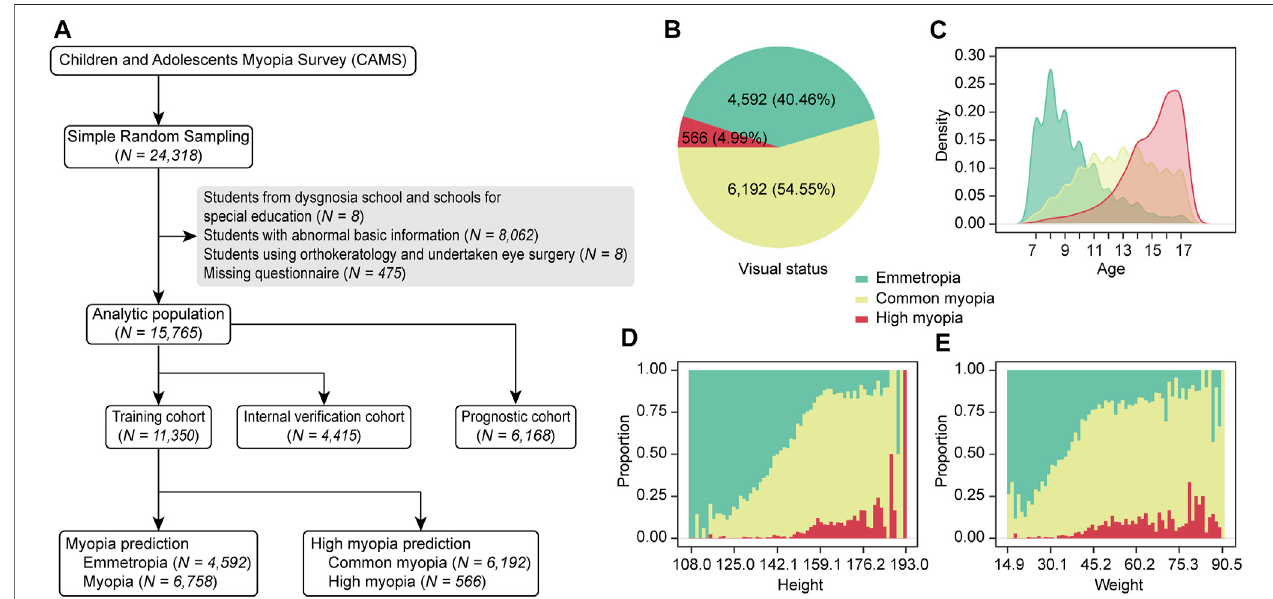
FIGURE 1 | Flowchart and distribution of the study cohort. (A) Numbers of participants. (B) Distribution of visual states in our cohort. (C) Age distribution of schoolchildren with various visual states. (D) Height distribution. (E) Weight distribution.